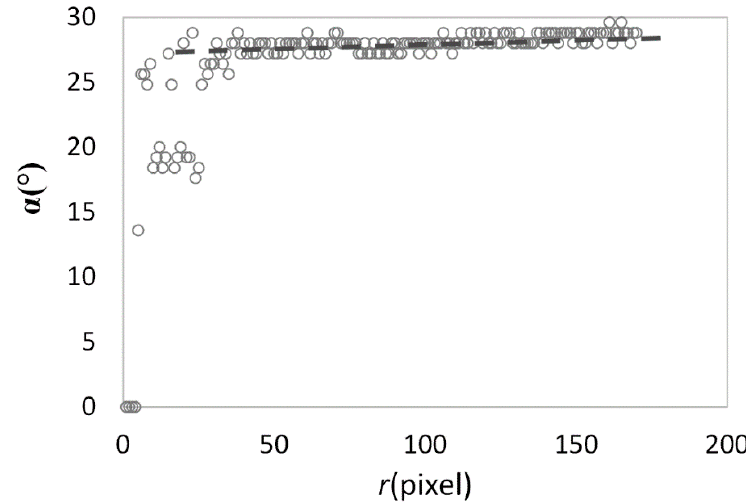
Figure 5. Scanning radius versus the wake angle. Note: the dash-line shows its converging trend.